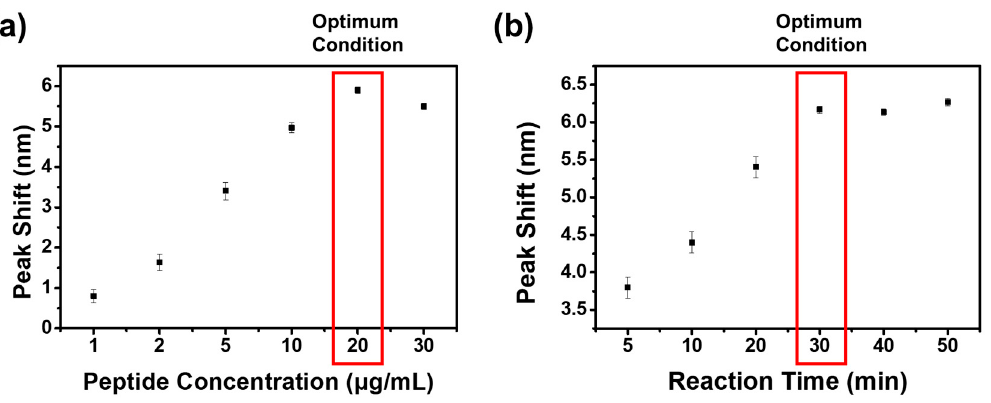
Figure 2. Optimization of LSPR sensor chip: ( a ) effect of peptide concentration on detection of fipronil, and ( b ) optimal reaction time with 20 µg mL − 1 of peptide.